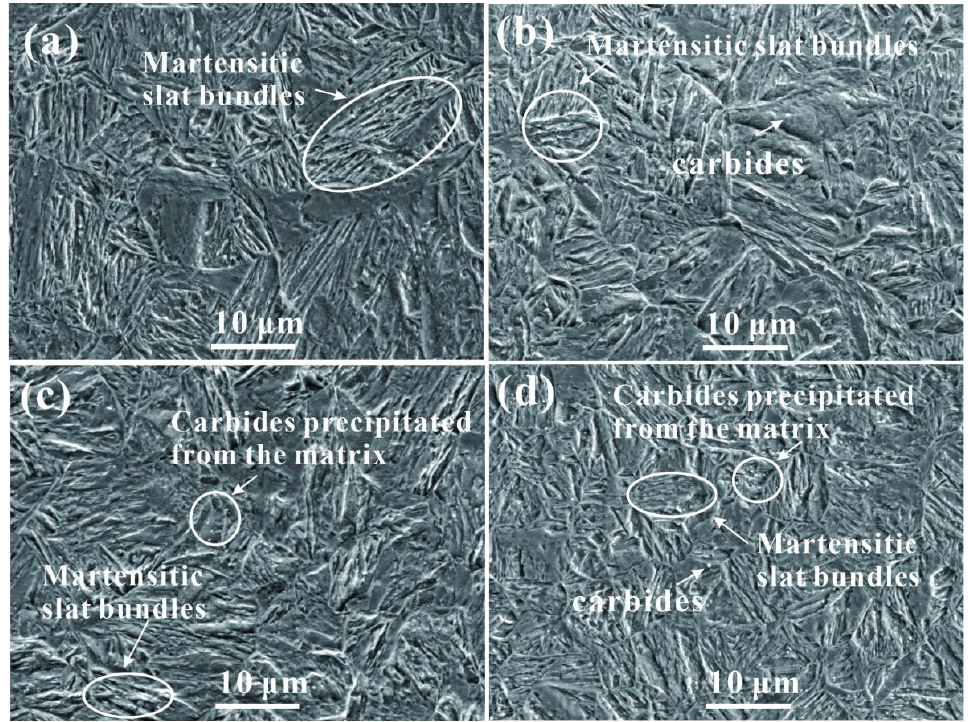
Figure 5. SEM images show the microstructure of the core of ( a ) CHT, ( b ) CT-80, ( c ) SCT-150 and ( d ) DCT-196 specimens.